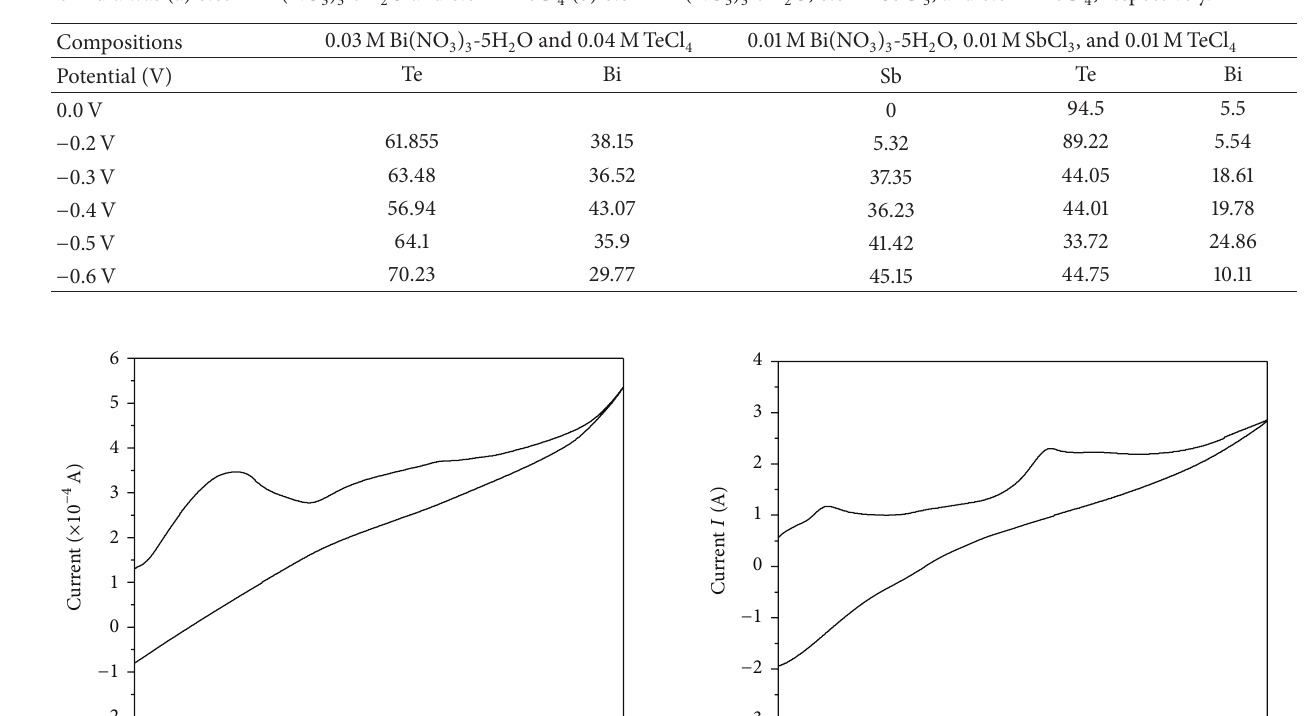
Table 1: Effects of deposition voltage on the composition of the ( Bi,Sb ) 2−𝑥 Te 3+𝑥 -based materials; the deposition time was 60min. Electrolyte formula was (a) 0.03 MBi(NO